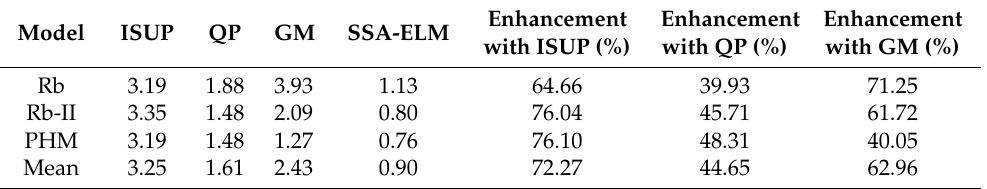
Table 6. The average RMS values of 6 h for different prediction models based on 24 h of SCB data (ns). Model ISUP QP GM SSA-ELM